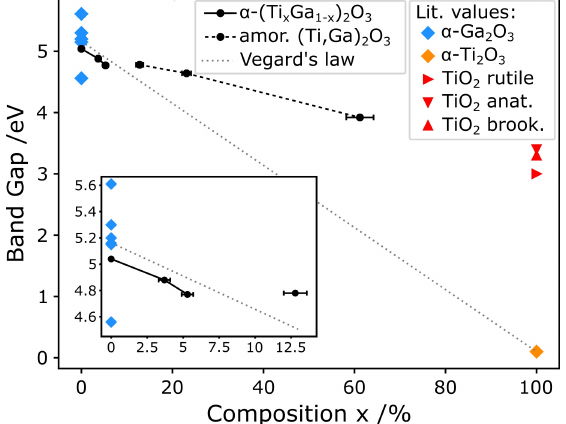
Figure 5. Plot showing the measured variation of band gap energy with the RBS composition alongside literature values of band gaps for pure oxides [1–5,30,56–62] and a Vegard’s law trend between α -Ga 2 O 3 and α -Ti 2 O 3 . The inset is an enlargement of the low Ti fraction region. The plot also differentiates between compositions based on whether crystallinity was observed by